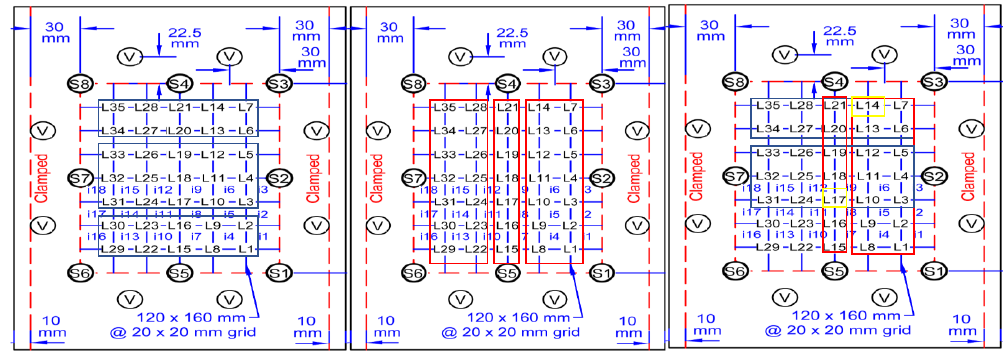
Figure 10. Division process of the plate to different location classes.